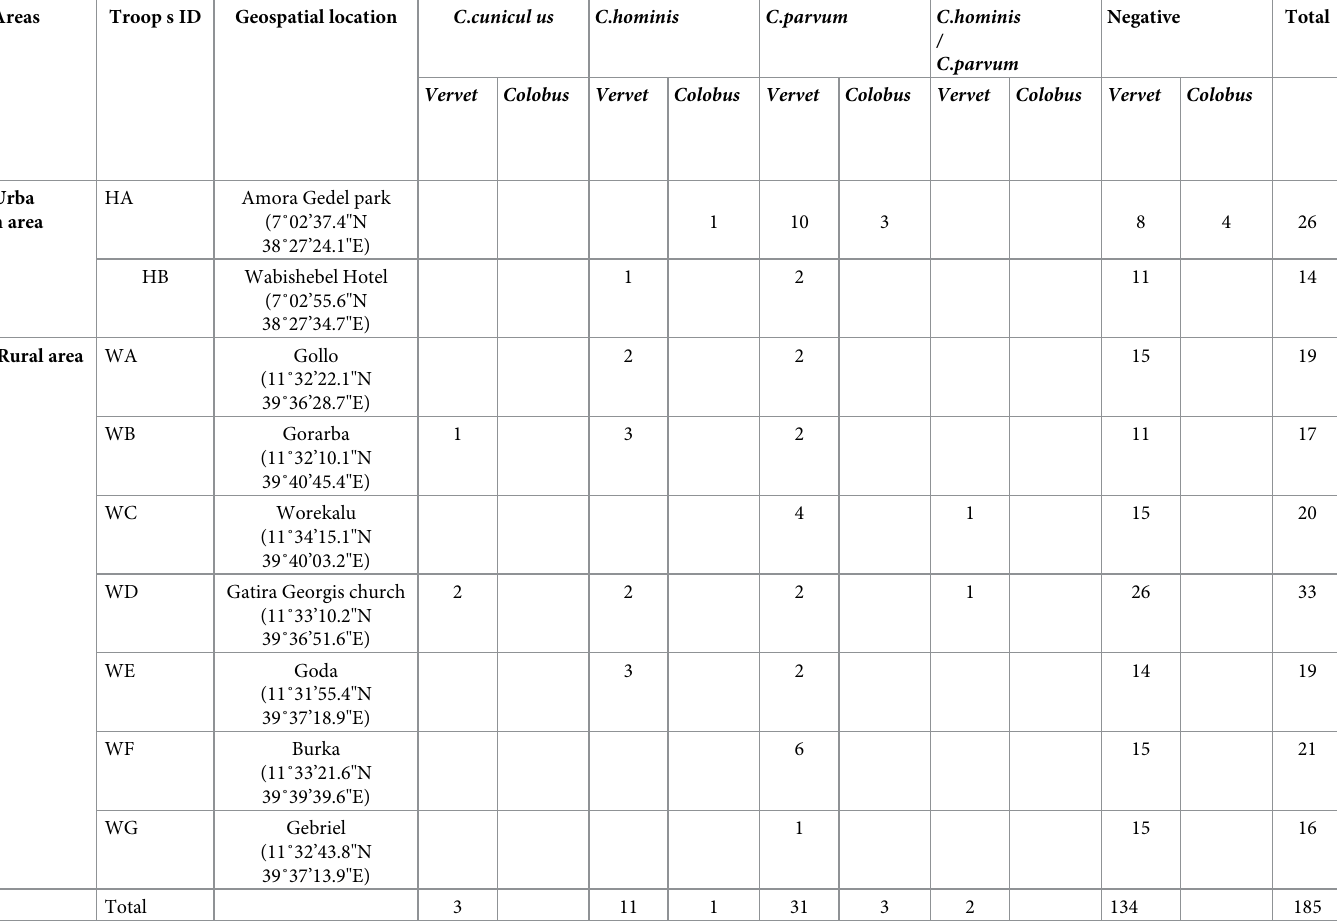
Table 1. Distribution of Cryptosporidium species infection in NHPs from Wurgissa and Hawassa areas in Ethiopia and their geospatial